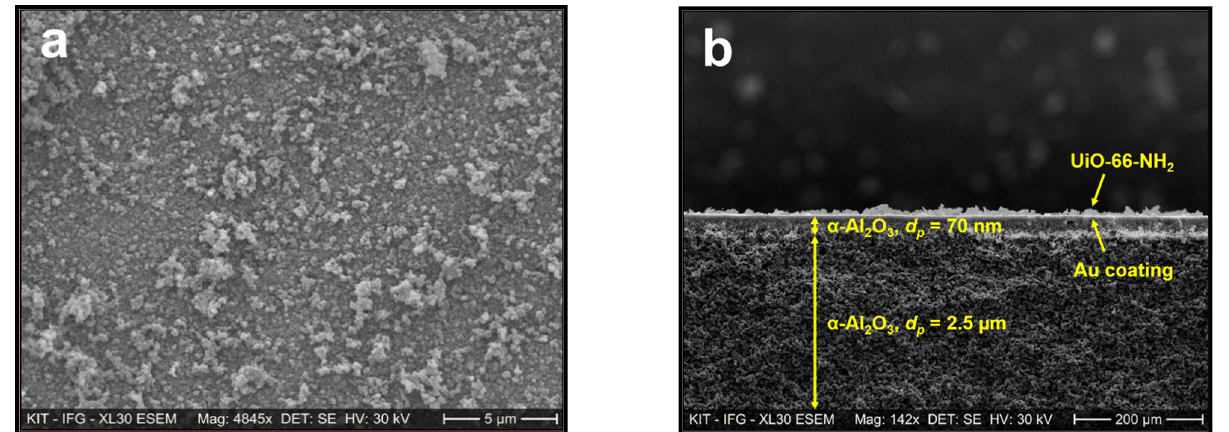
Figure 5. SEM images of ( a ) the top surface and ( b ) the cross-section of the membrane U-OP.